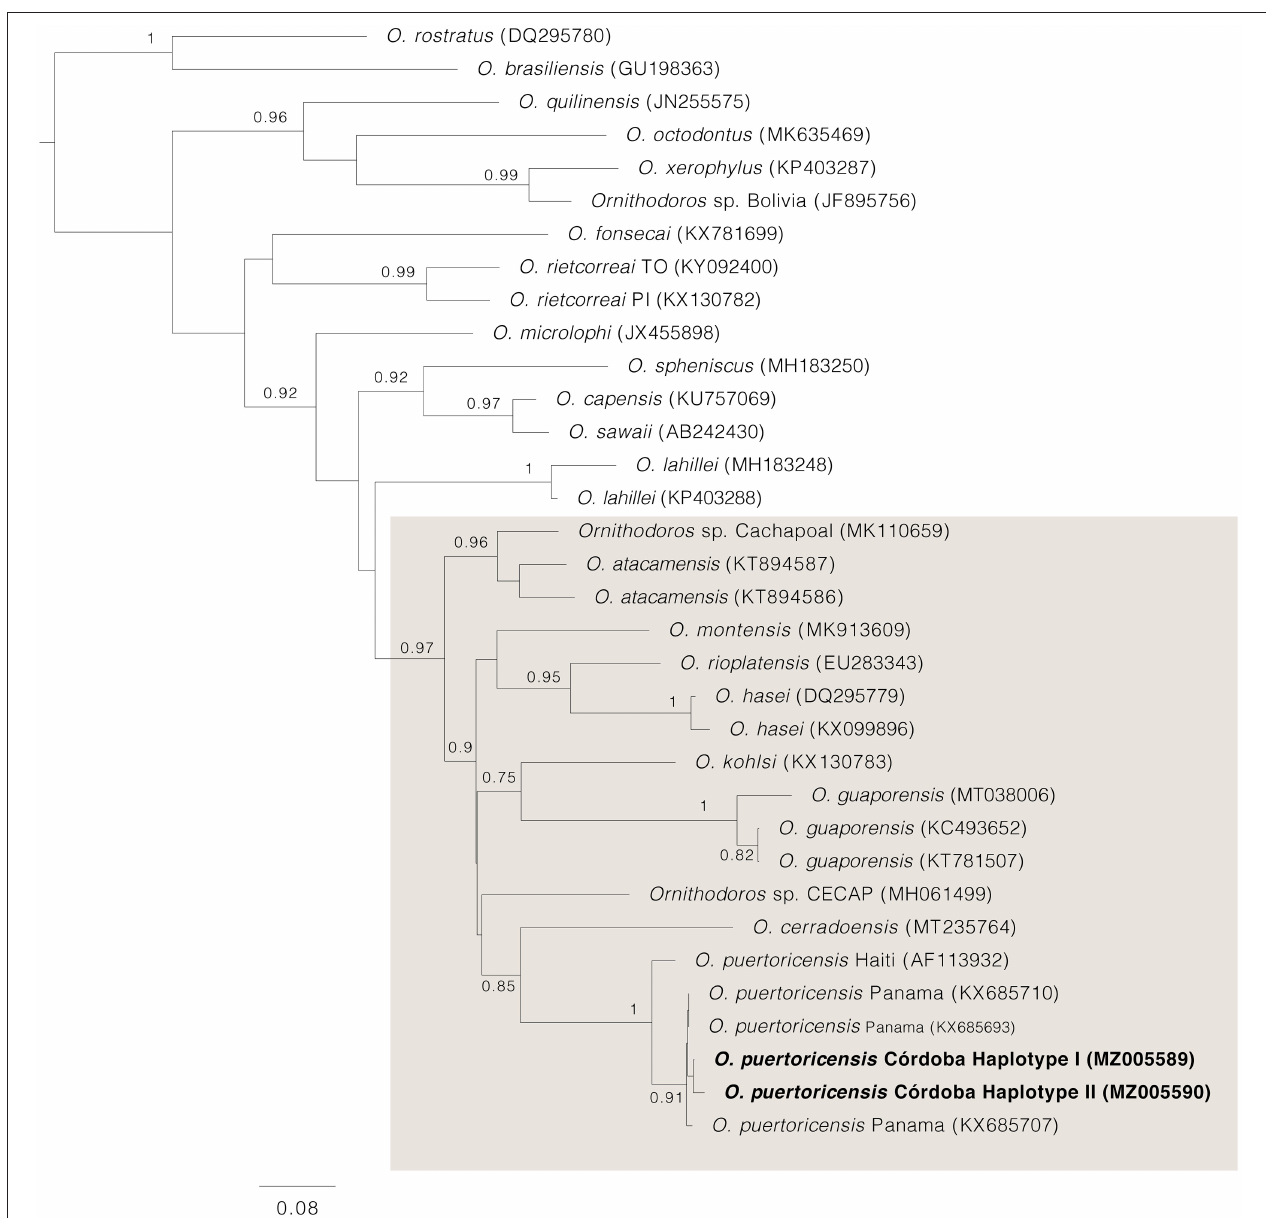
FIGURE 4 | Approximately maximum likelihood phylogenetic tree for a subset of Ornithodoros spp. Support values > 0.75 are shown above or below main branches. The position of O. puertoricensis collected at Córdoba department is highlighted in bold. The O. talaje group is boxed in gray.